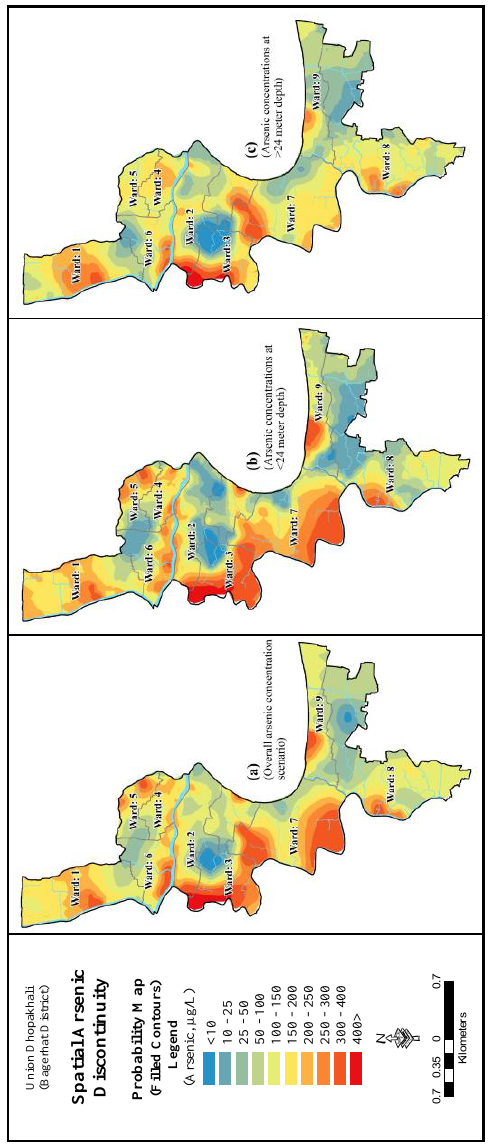
Figure 4. Spatial arsenic discontinuity: (a) Overall scenario in the study site; (b) at the depth less than 24 meters; and (c) at the depth more than 24